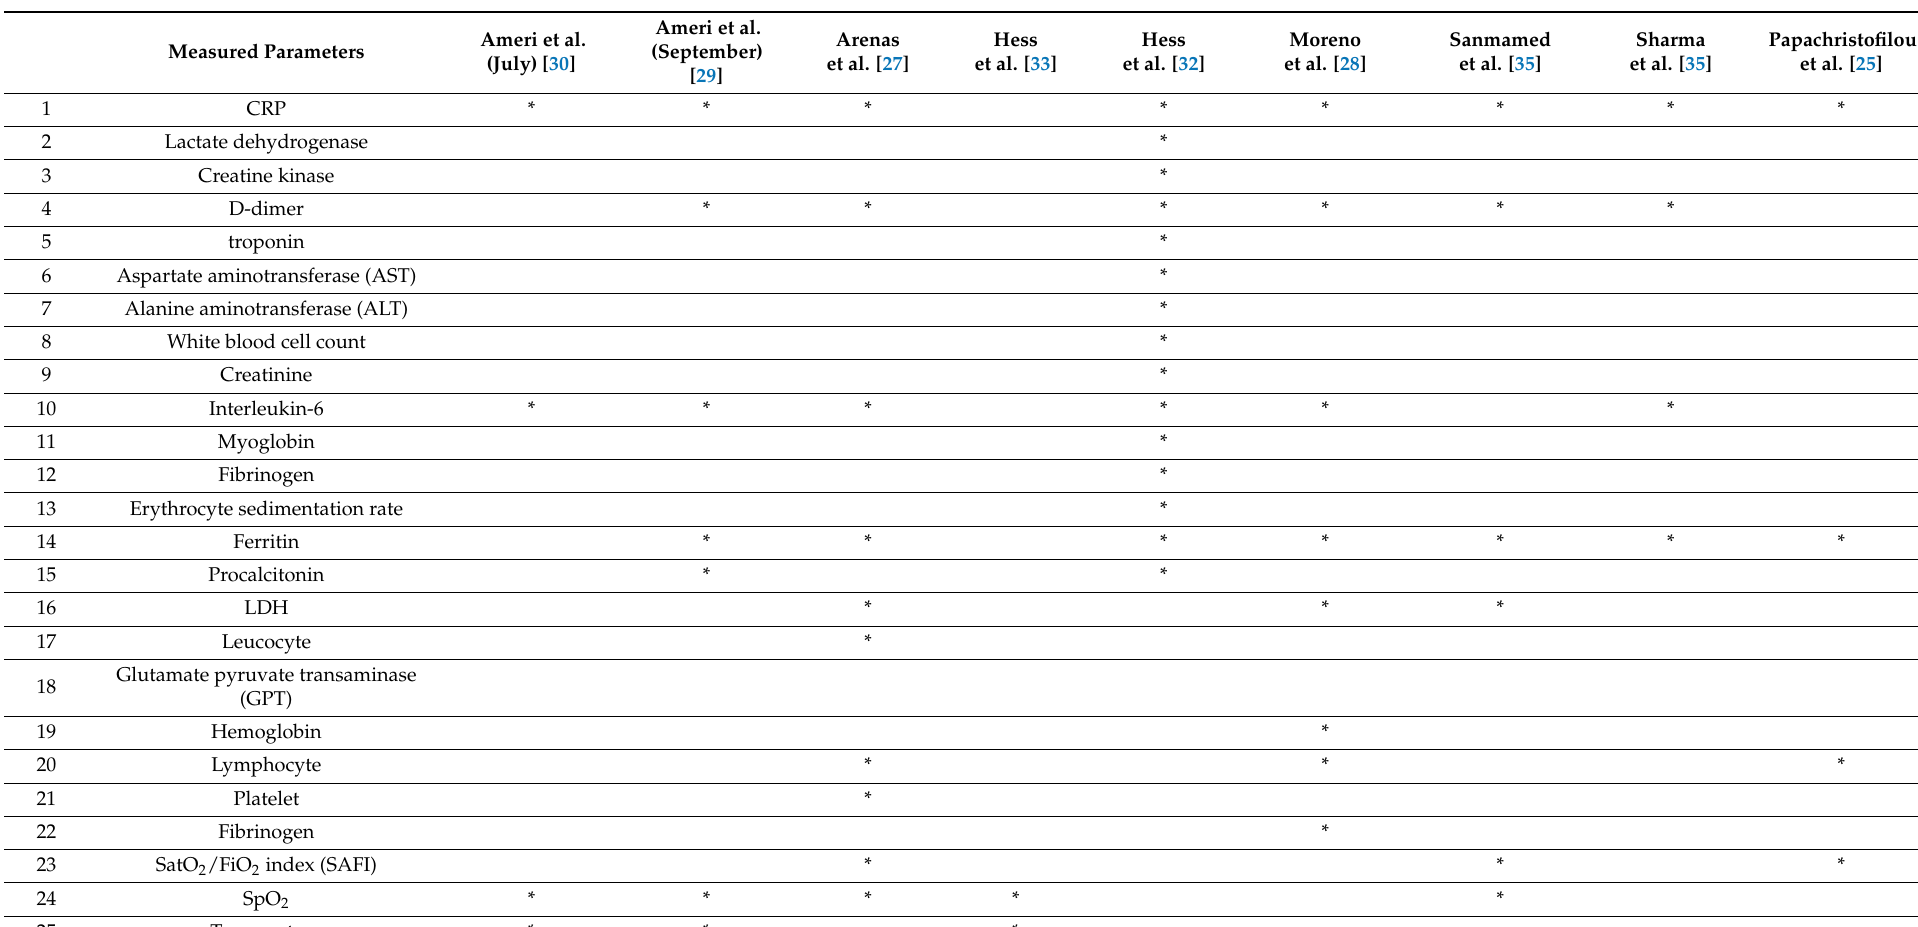
Table A1. Measured parameters in the reviewed